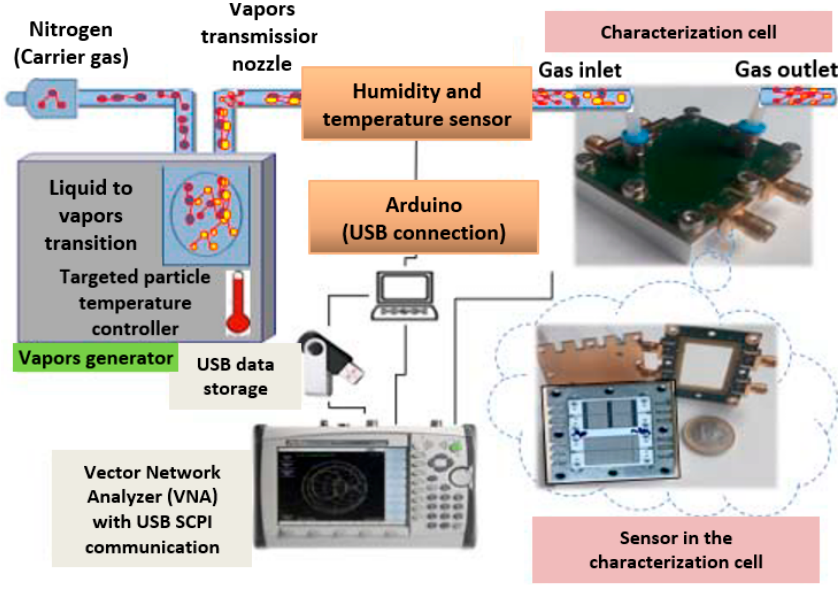
Figure 11. The measuring bench under gas.